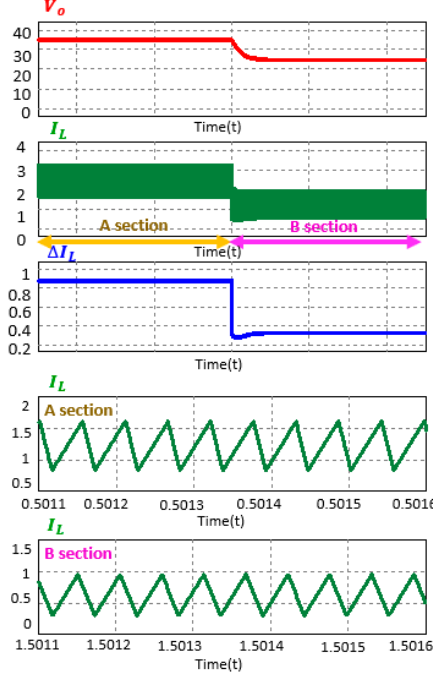
Figure 18. Proposed hybrid current mode controller inductor current response to a lowered output voltage.